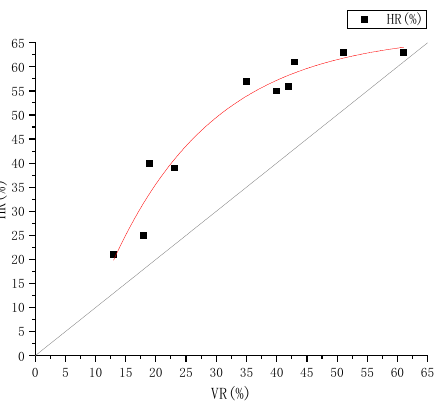
Figure 2. Experimental results of thermal pollution in bioretention facilities.